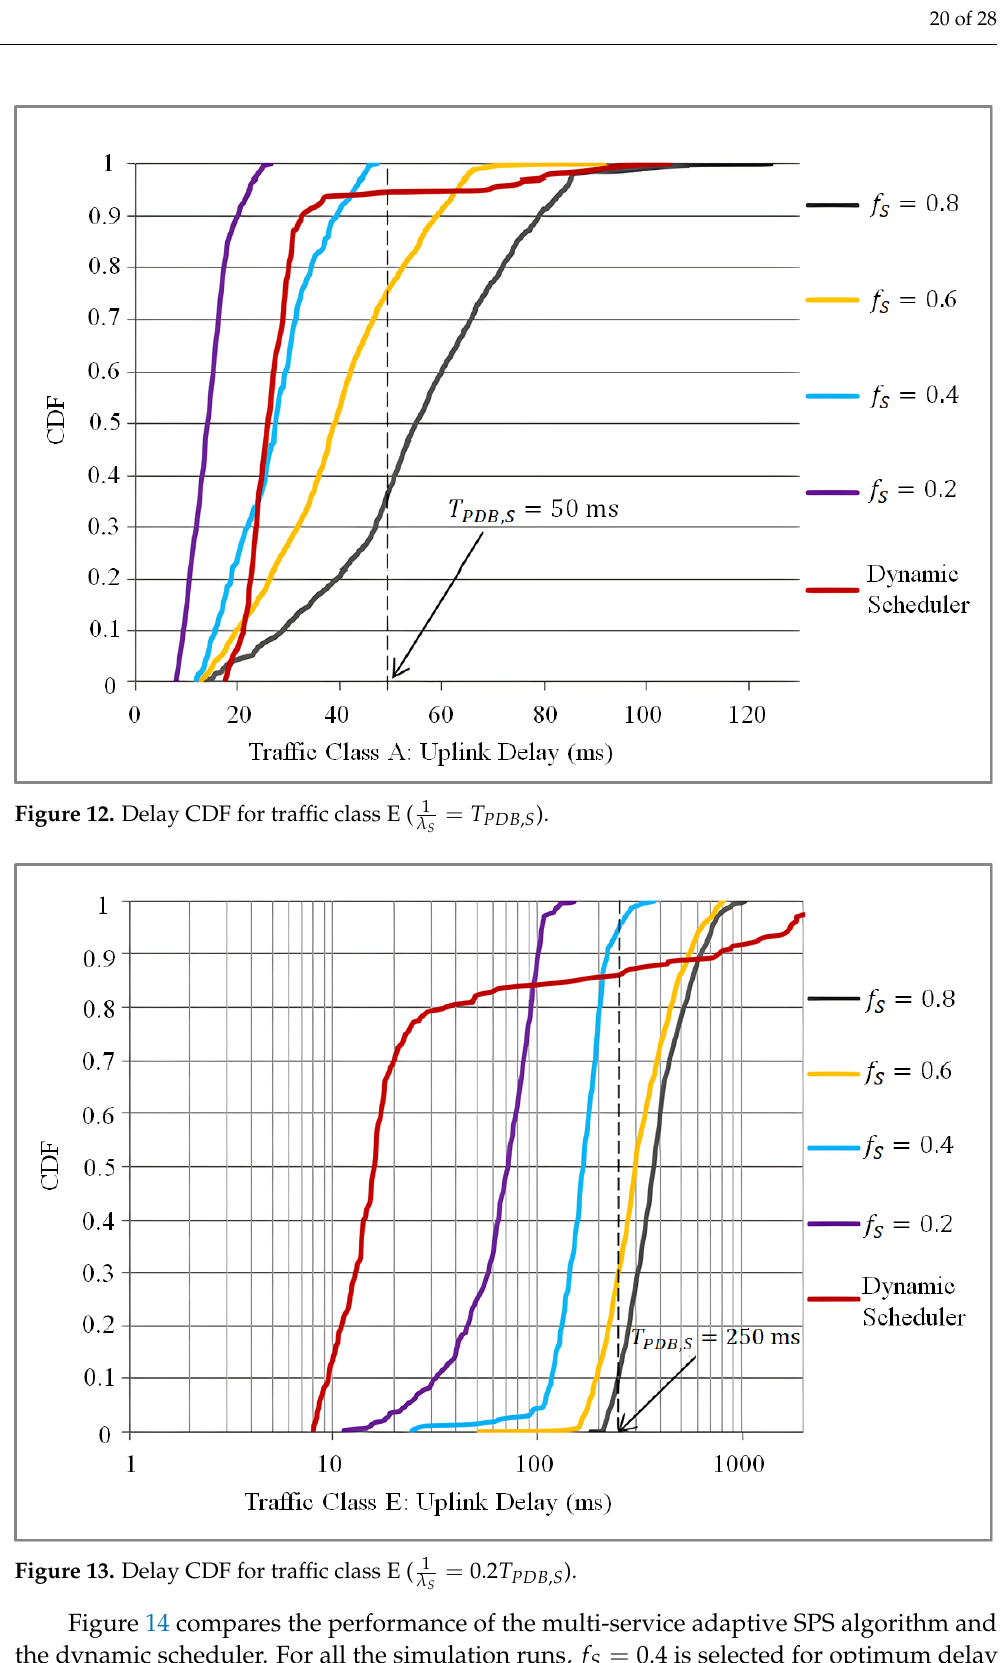
Figure 13. Delay CDF for traffic class E ( 1